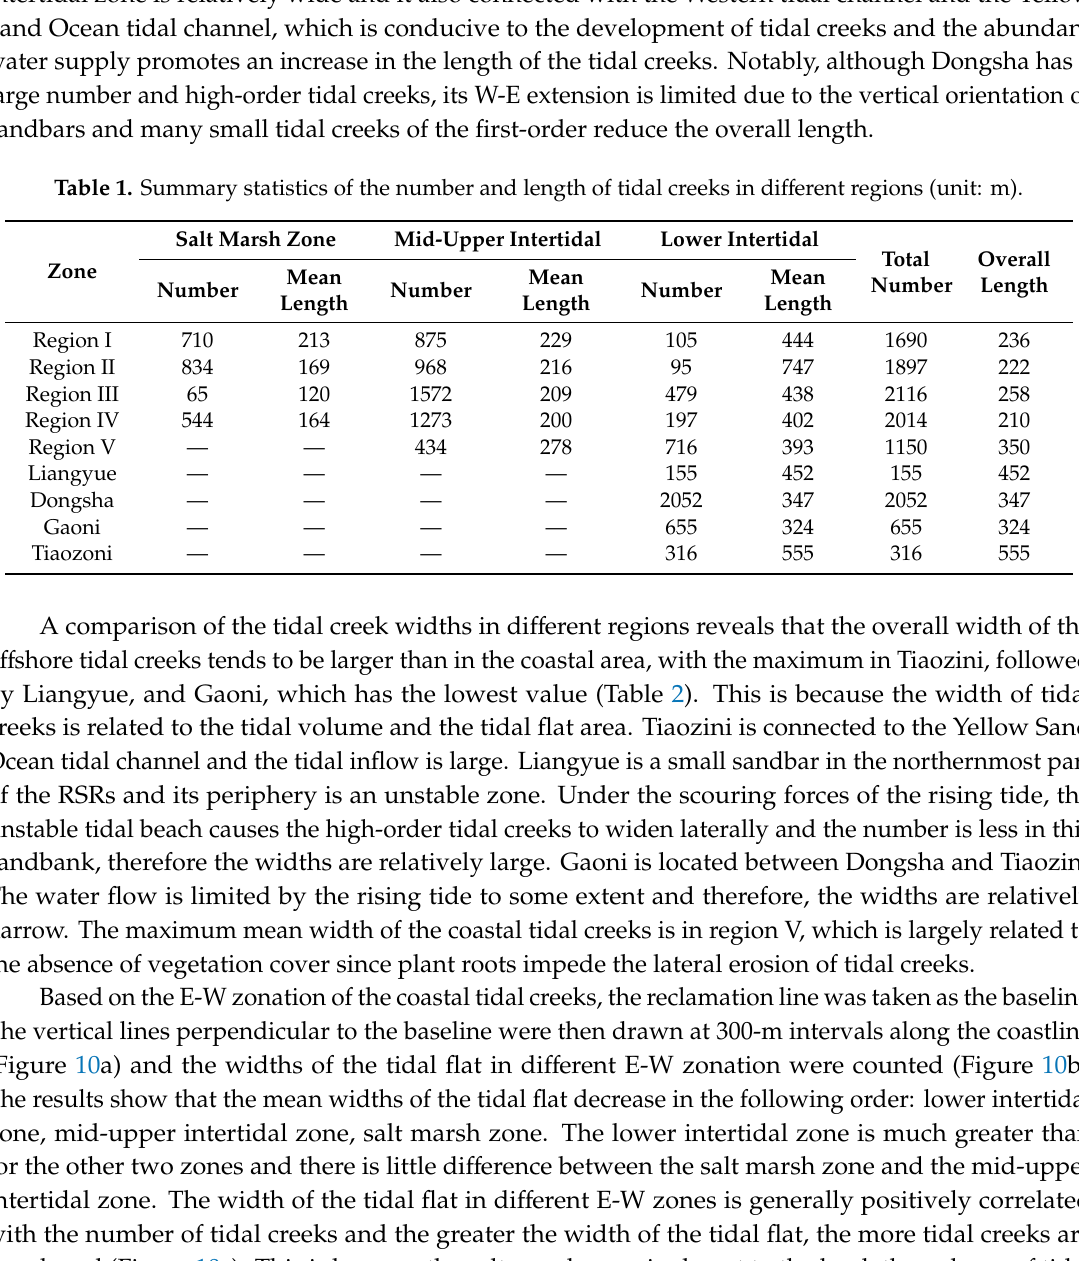
Table 1. Summary statistics of the number and length of tidal creeks in di ff erent regions (unit: m). Salt Marsh Zone Mid-Upper Intertidal Lower Intertidal Zone